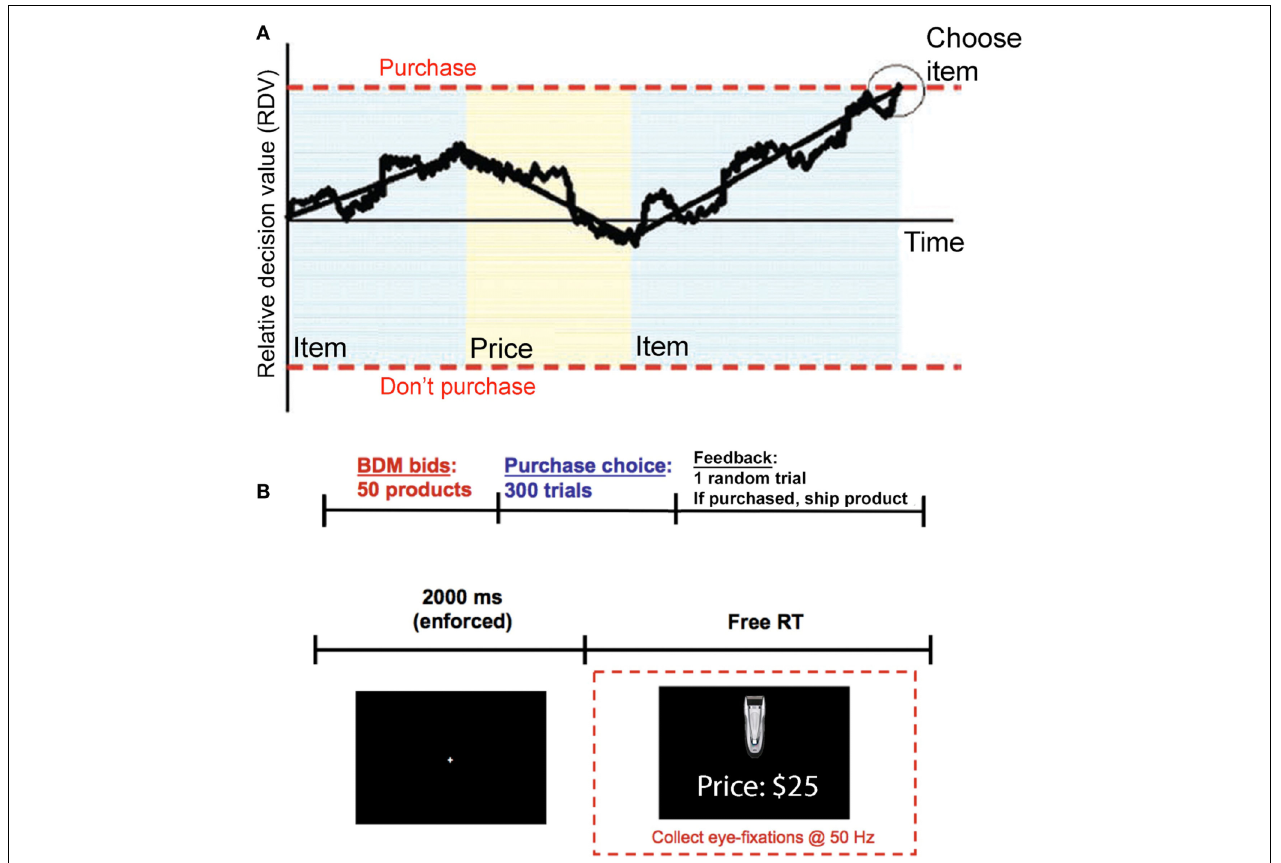
BDM auction.Then subjects make 300 purchasing choices (the 50 products at six different prices). At the end of the experiment one trial from the combined tasks is randomly chosen and the subject is paid and/or is shipped the chosen product. (Bottom)Within a choice trial, subjects must first fixate at the center of the screen for 2s.They are then presented with an item and a price and given unlimited self-paced time to decide whether to buy the item at that